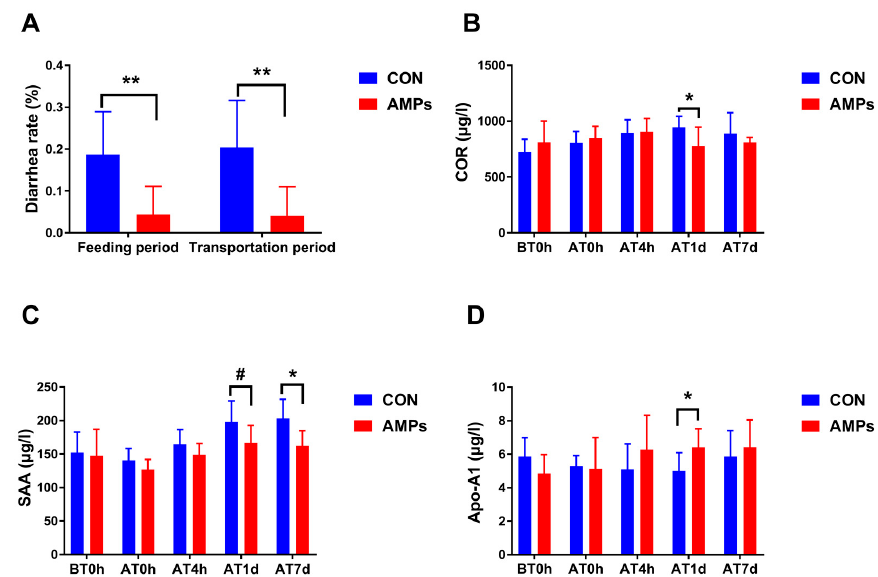
Figure 2. Effect of AMPs on diarrhea rate ( A ) and serum hormone ( B – D ) in ragdolls. Symbol (*) indicates statistically significant differences between two groups (* p < 0.05 and ** p < 0.01), and symbol (#) indicates difference tendencies (0.05 < # p < 0.10). BT0h, right before transportation; AT0h, right after transportation; AT4h, 4 h after transportation; AT1d, 1 day after transportation; AT7d, 7 days after transportation.